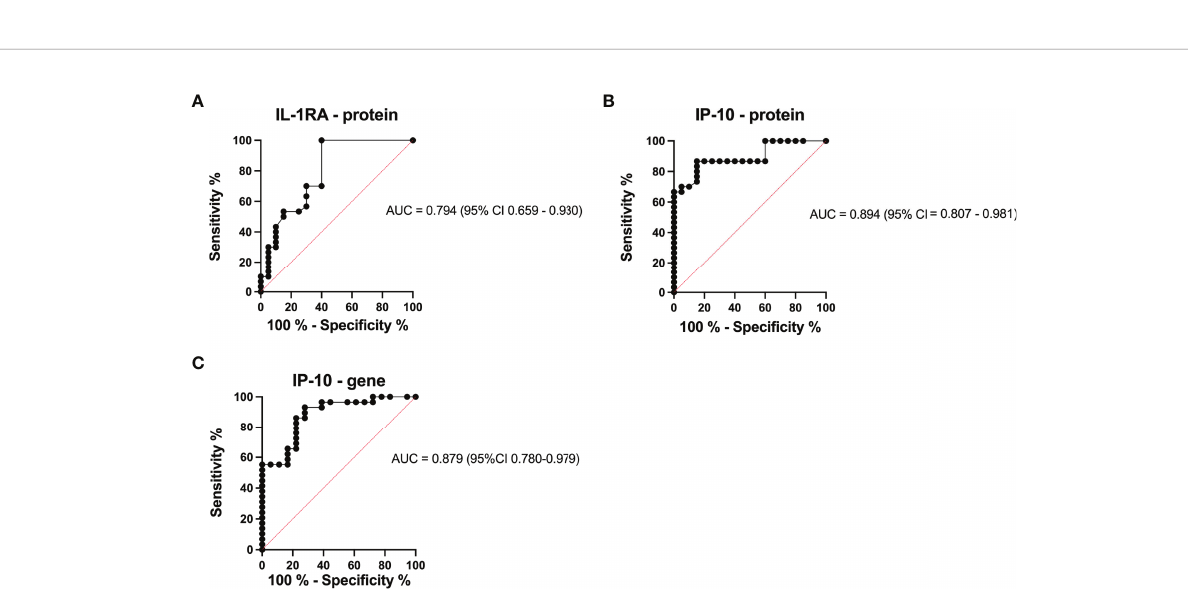
FIGURE 3 | IP-10 is upregulated in whole blood of TB patients. Gene expression of (A) IL-1RA, (B) IL-6, and (C) IP-10 in the whole blood of healthy (n=20), LTBI (n=20), and TB (n=30) participants normalized to a house-keeping gene, RPLP1. P < 0.05 was considered statistically signi fi cant. Data were analyzed using the one- way ANOVA and followed by a multiple comparisons test using Tukey ’ s test. Tukey ’ s p -values have been reported in the above fi gure and illustrate the differences observed between groups.